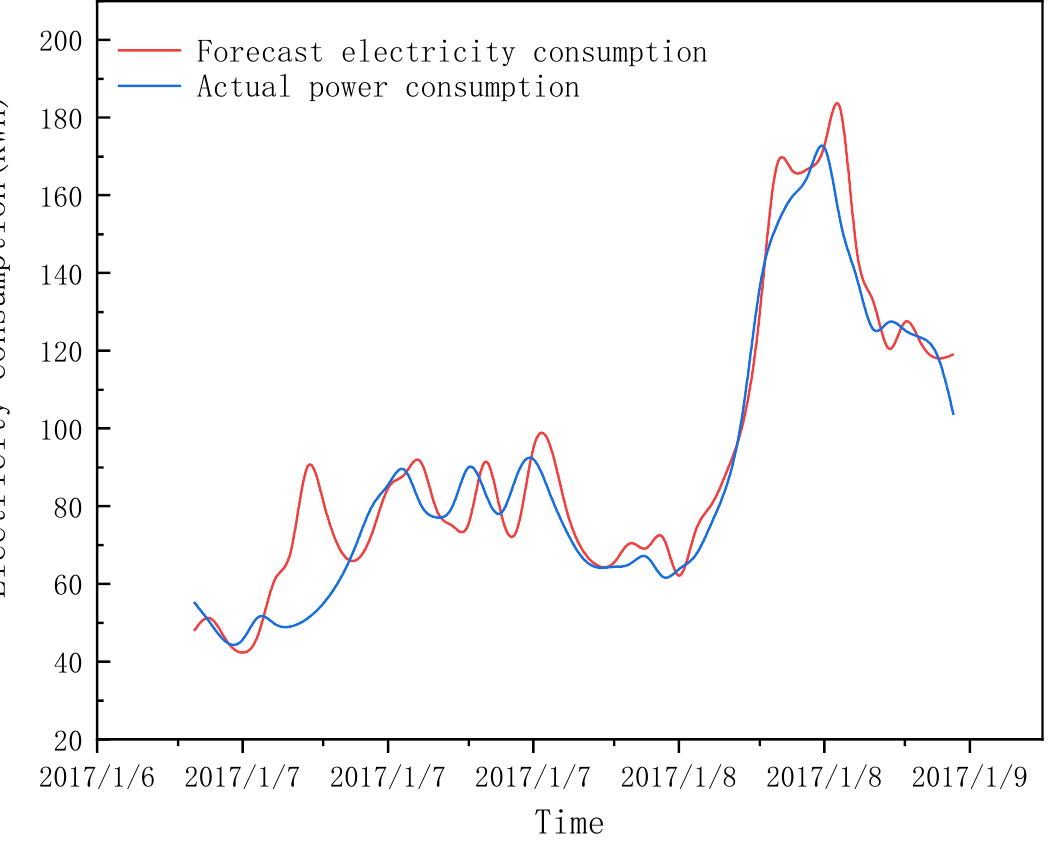
Figure 11. Forecast of air conditioning energy consumption on non-working days in winter.